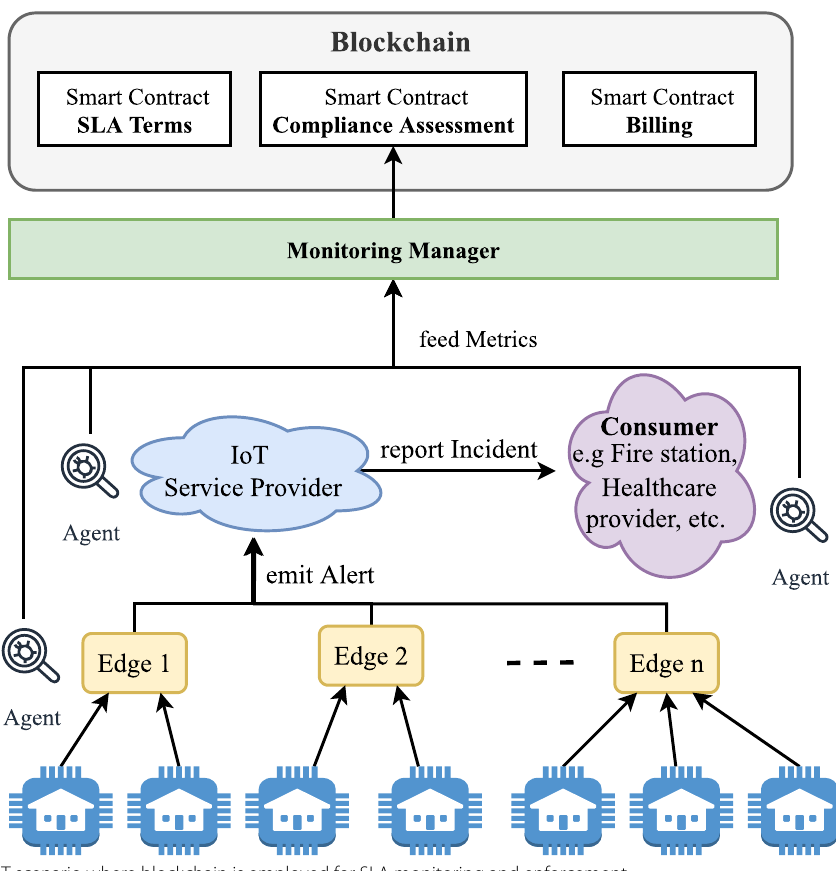
Fig. 4 Motivating IoT scenario where blockchain is employed for SLA monitoring and enforcement